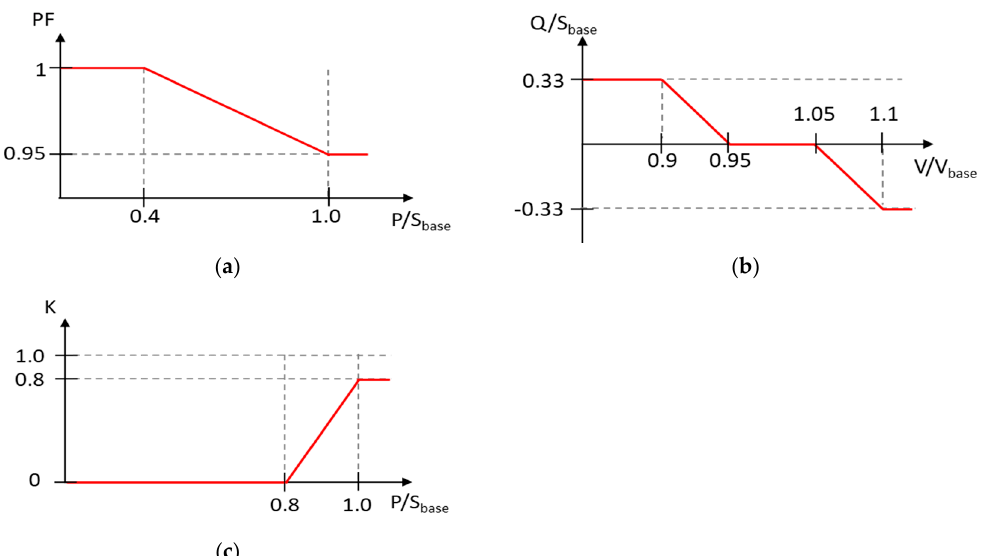
Figure 8. Flowchart of load flow including reactive power control of renewable energy system.